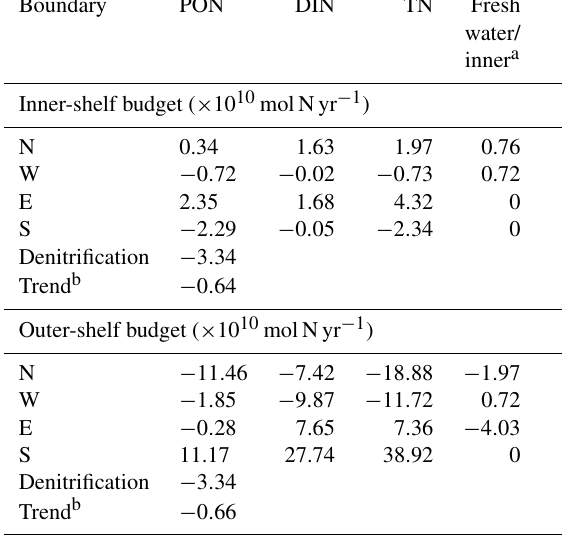
Table 1. Nutrient budget in moles of nitrogen per year for the inner (50m isobath) and outer (250m isobath) Yucatán shelf, computed at each boundary (N, W, E, and S; see Fig. 1a) using cross-shelf ve- locities. The flux of nutrients is integrated through the water column and temporally averaged using the period 2002–2010 to compute the budget from daily model fields. Positive (negative) values repre- sent sources (sinks) of nutrients. Denitrification is always a nitrogen removal